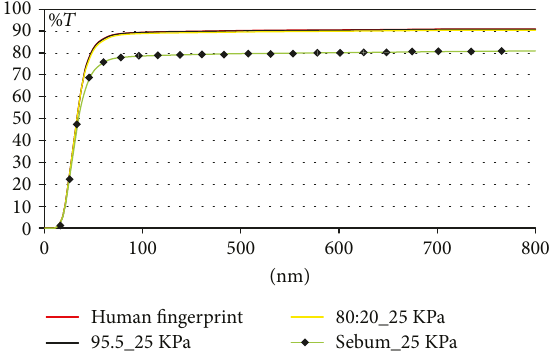
Figure 3: T % spectra on glass with human and arti fi cial fi ngerprints composed by di ff erent ratio %